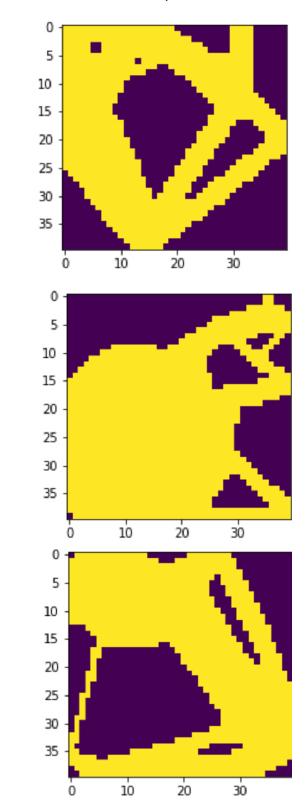
Figure 8. Outputs of Res-U-Net and ground truth from Dataset #1.